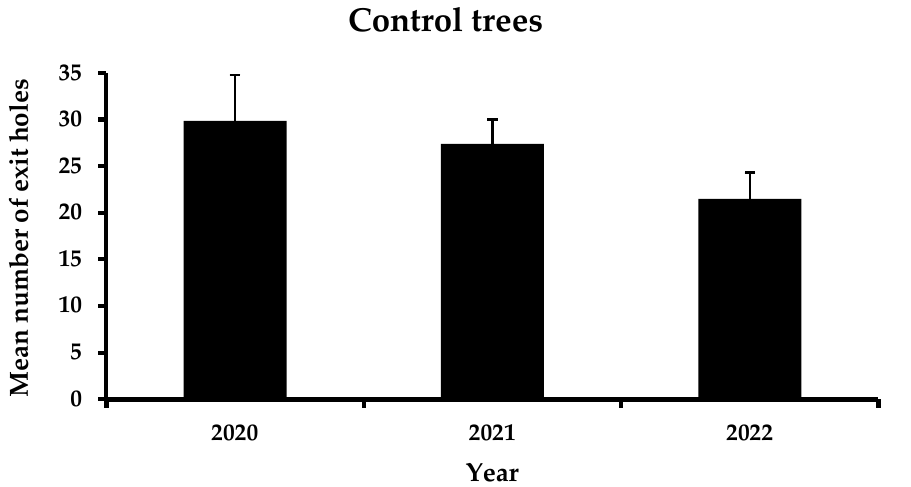
Figure 3. Mean number (+ Standard Error) of Xylotrechus chinensis exit holes from the control trees during 2020–2022. ( F = 1.7, DF = 2, 29, p = 0.21). No letters above columns indicate no significant differences.